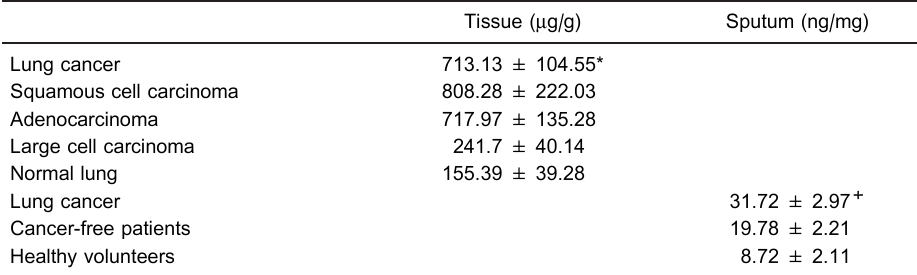
Table 3. Tissue and sputum hyaluronan (HA)